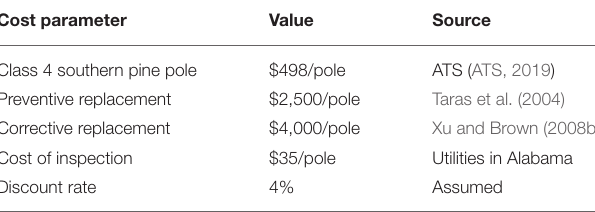
TABLE 2 | Cost analysis